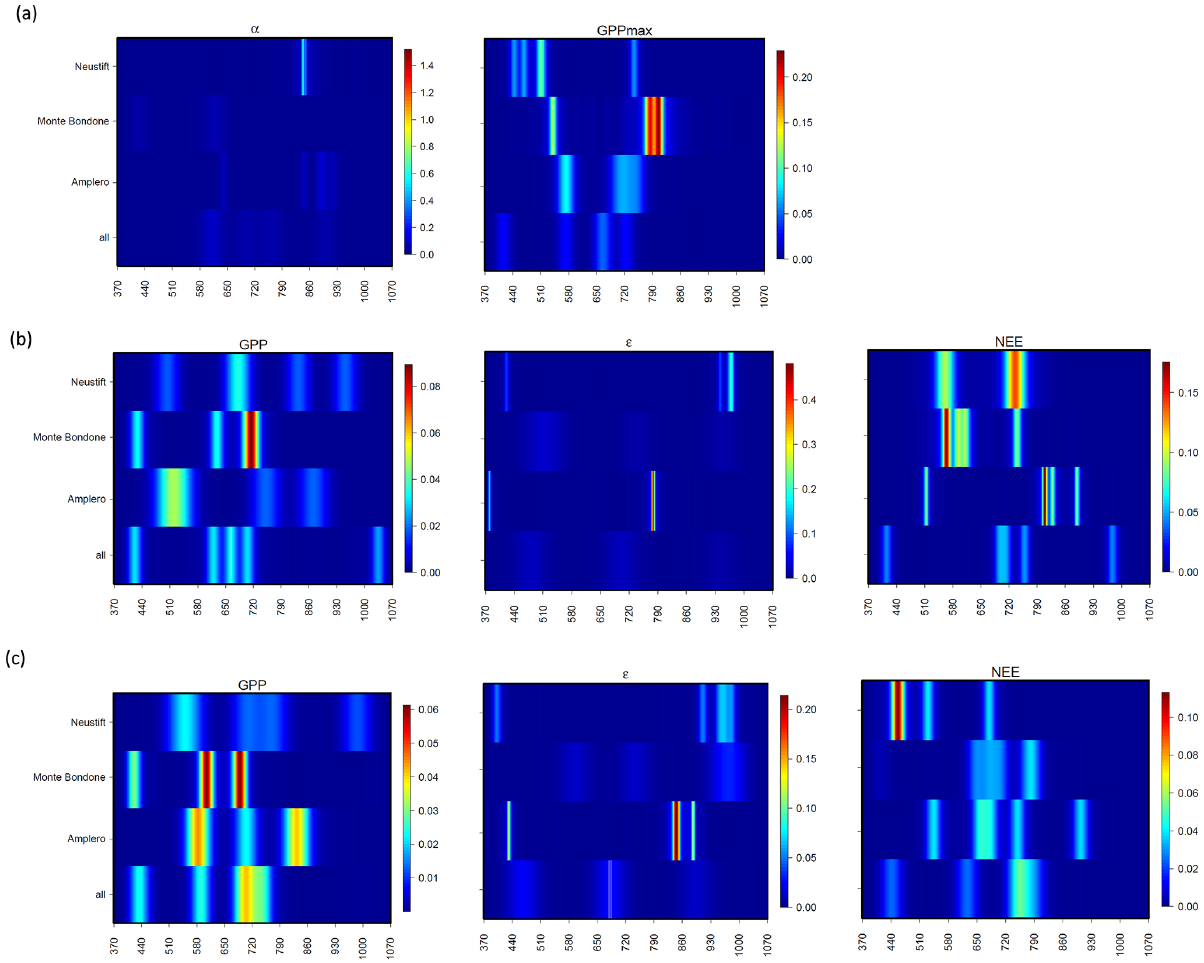
Figure 9. Results of the GA–rF method for band selection for Amplero, Neustift, Monte Bondone and all sites pooled for (a) α and GPP max , (b) midday average ε and CO 2 fluxes (NEE and GPP); (c) daily average ε and CO 2 fluxes (NEE and